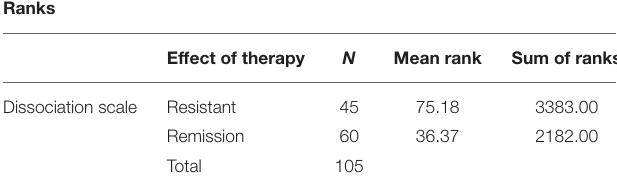
TABLE 2 | Mann-Whitney U test—description.